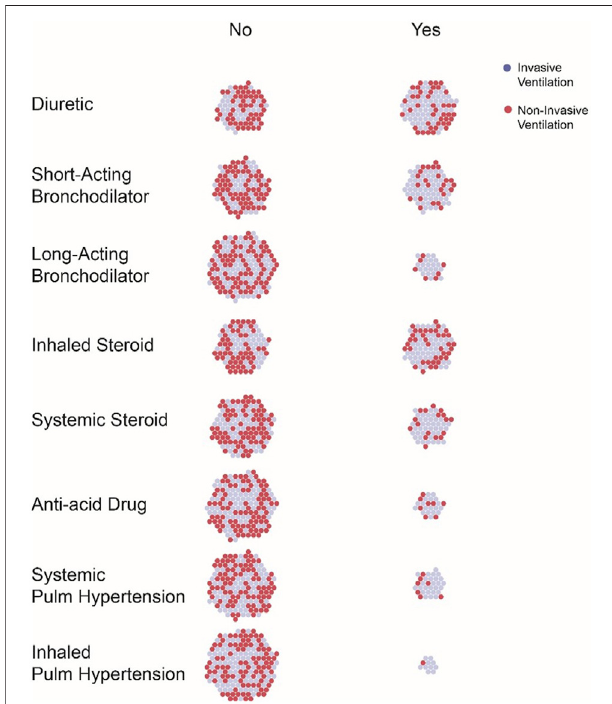
FIGURE 1 | Drug Class Exposure by Ventilation